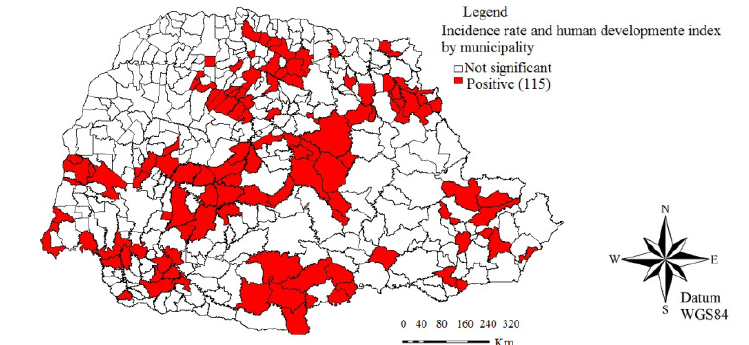
Figure 6. Map of the spatial correlation between the incidence rate of the number of confirmed cases for COVID-19 from June to December 2020 and the Theil-L index using the multivariate Geary local ) , in Paraná. index ( C M i